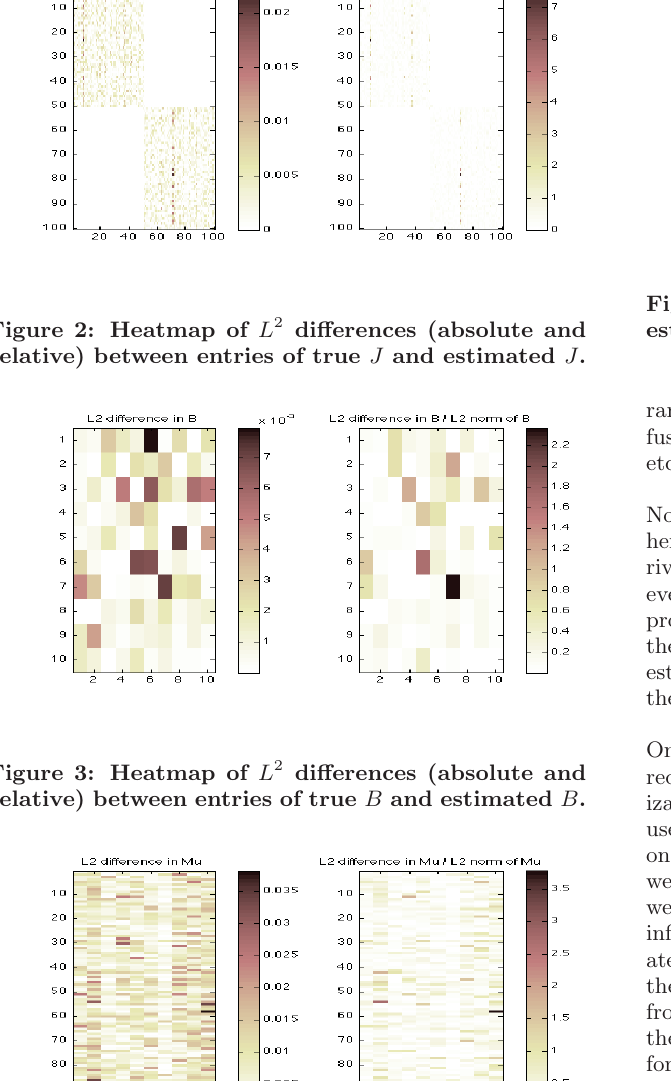
Figure 4: Heatmap of L 2 differences (absolute and relative) between entries of true μ and estimated μ .